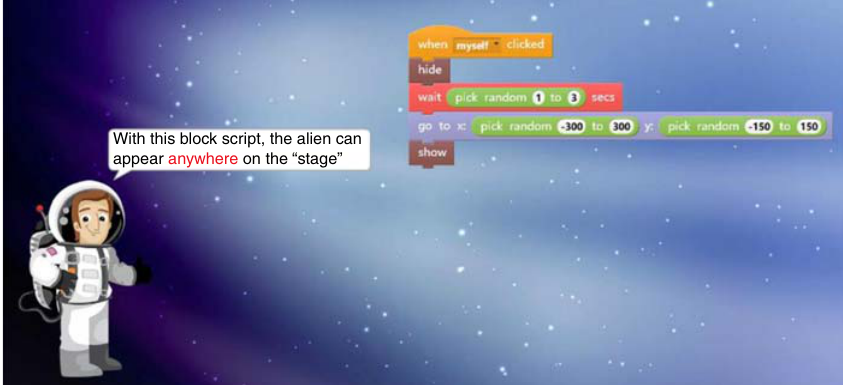
Figure 2. Introduction